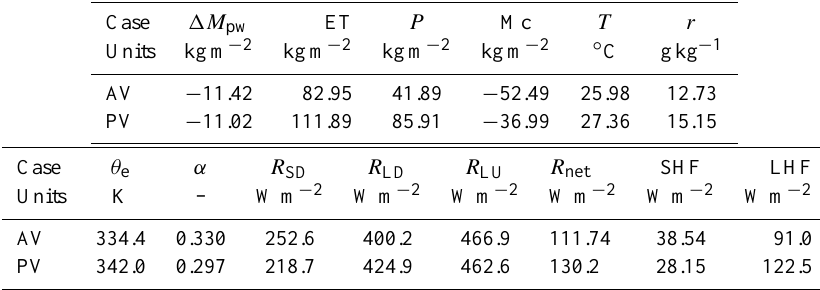
Table 4. Hydrologic monthly means within the bounded area above the Gran Chaco case study, April 2003. Total change in column precip- itable water for the month per square meter (cid:49)M pw , evapotranspiration ET, precipitation P and resolved moisture convergence Mc, 55m air temperature T , mixing ration (55m) r , equivalent potential temperature θ e , surface albedo to shortwave radiation α , downwelling shortwave radiation R SD , downwelling longwave radiation R LD , upwelling longwave radiation R LU , net surface radiation R net , sensible heat flux SHF and latent heat flux LHF.